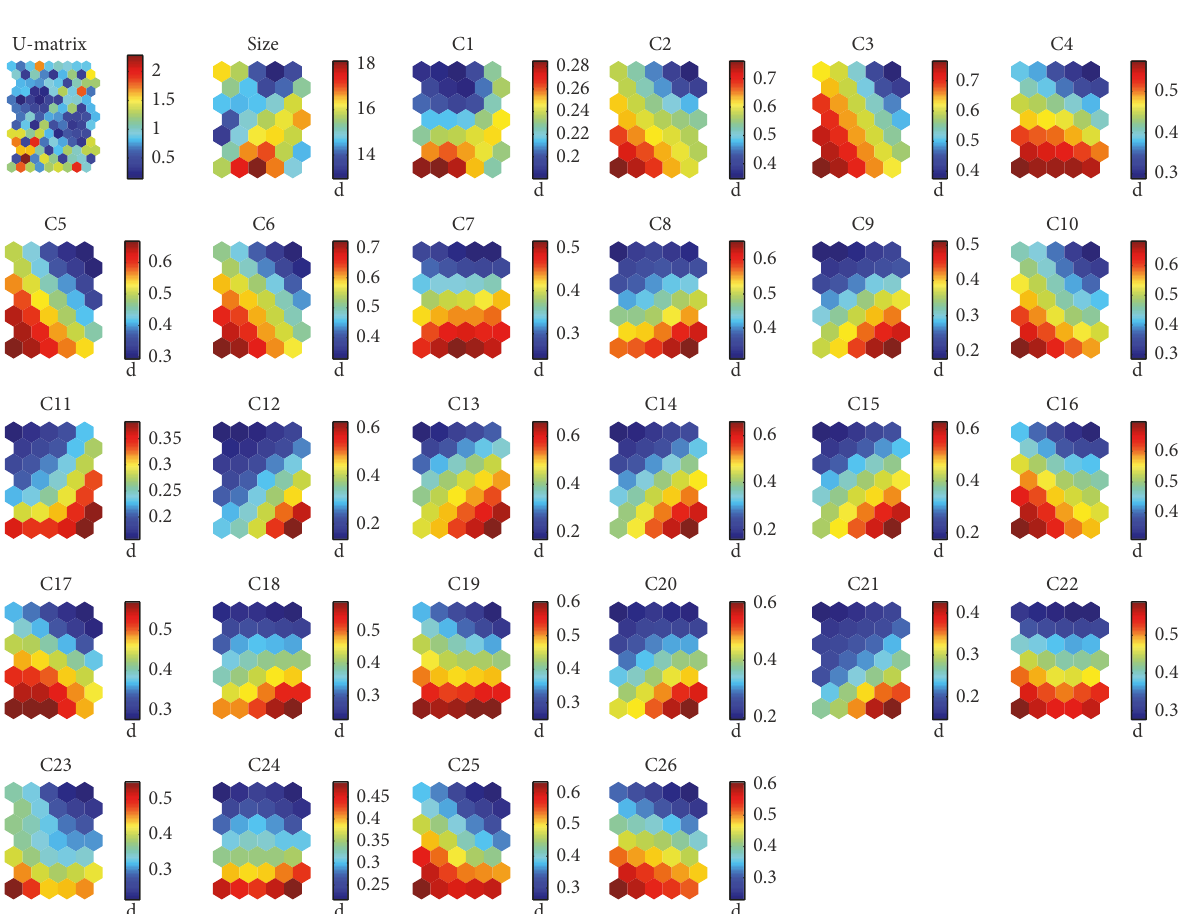
Figure 3: SOM U-matrix and component plane matrices using a 7 × 5 hexagonal SOM.